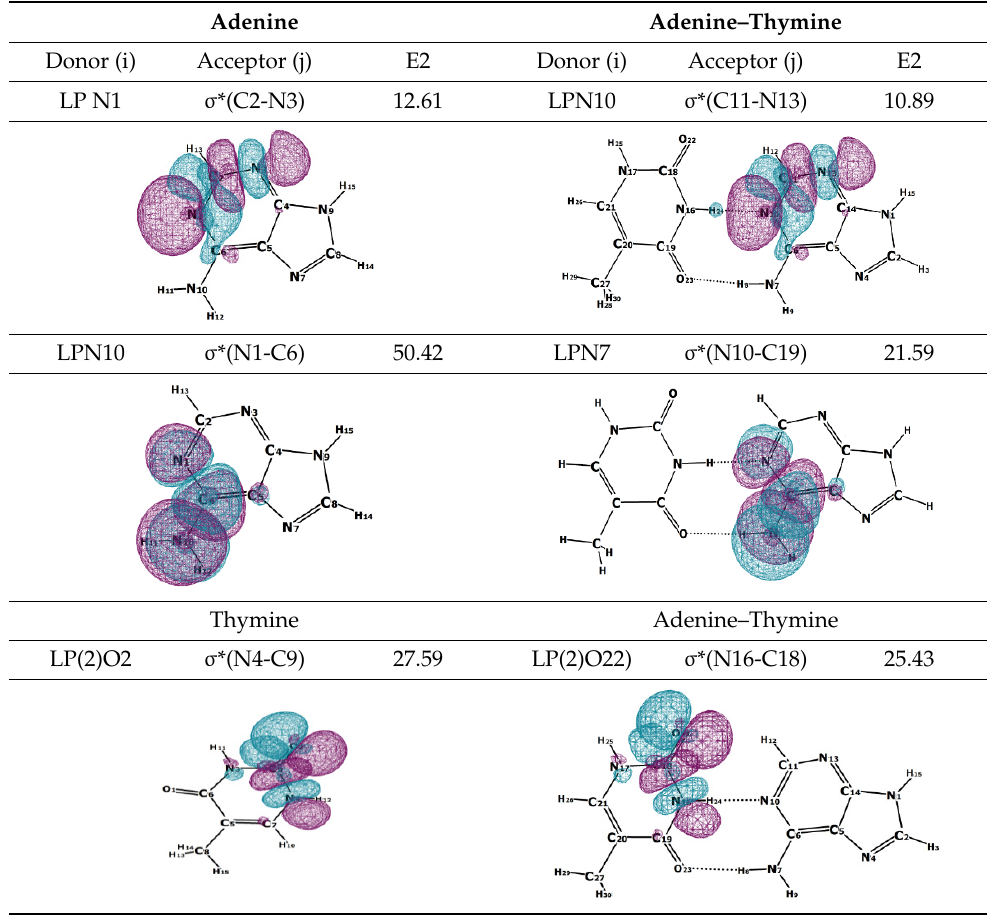
Table 1. Second-order perturbation theory analysis in NBO basis for non-bonded interactions in adenine and thymine molecules at the B3LYP/6-31G* level of theory. Adenine